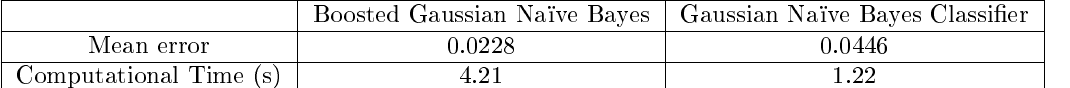
Table 1. Comparison of the results of the two methods.